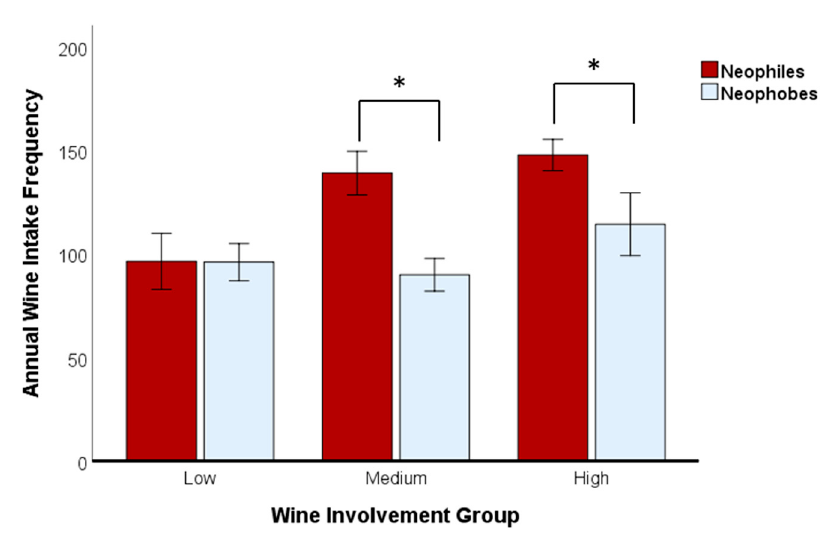
Figure 5. Annual wine intake frequency as a function of neophilia/neophobia and degree of wine involvement. Error bars represent the standard error for each condition mean. Asterisk (*) denotes a significant difference between groups.